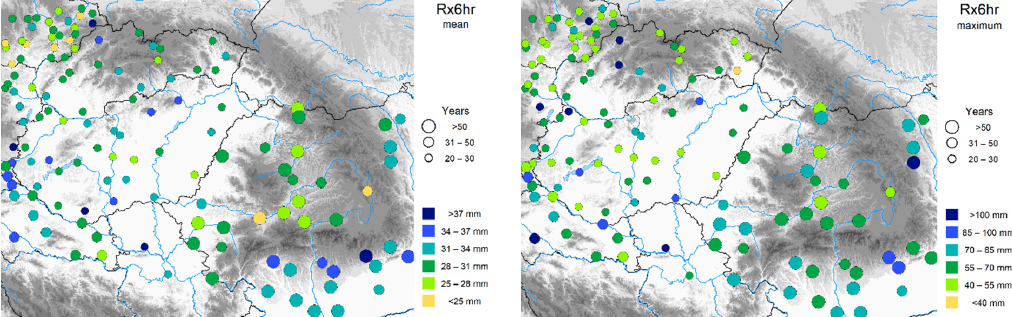
Figure 4. Annual average of 3-h maxima (Rx3hr) ( left ) and the maximum 3-h precipitation ( right ). The circles and their sizes are the same as in Figure 3.